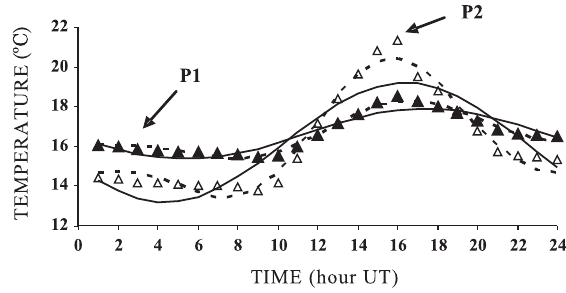
Figure 3. Time-course of temperature at mineral soil surface measured ( , ) and simulated with the first ( ___ ) and the first two Fourier harmonics ( --- ) in a pine-forested Haplic Podzol, with (P1) and without (P2) litter layer, on day M (moist soil).